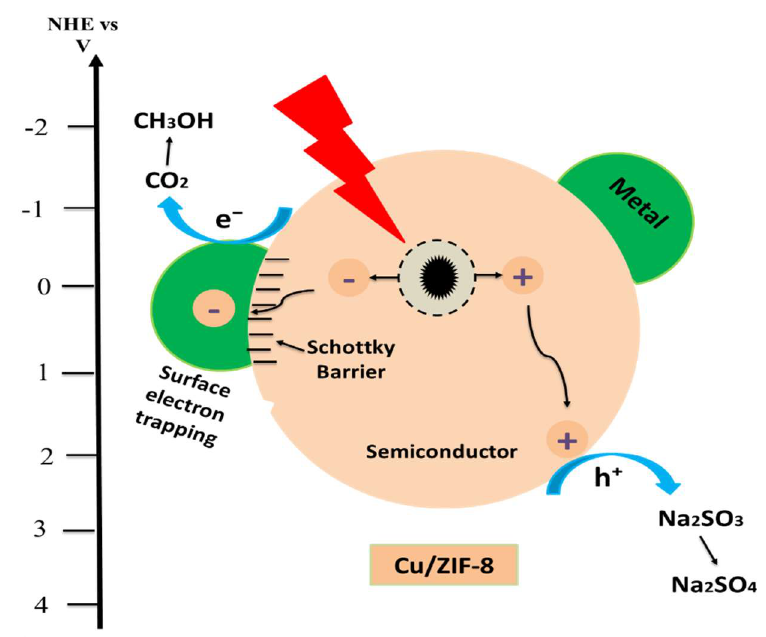
Figure 9. Schematic reduction activity of CO 2 to methanol over Cu/ZIF-8 photocatalyst under visible light irradiation.